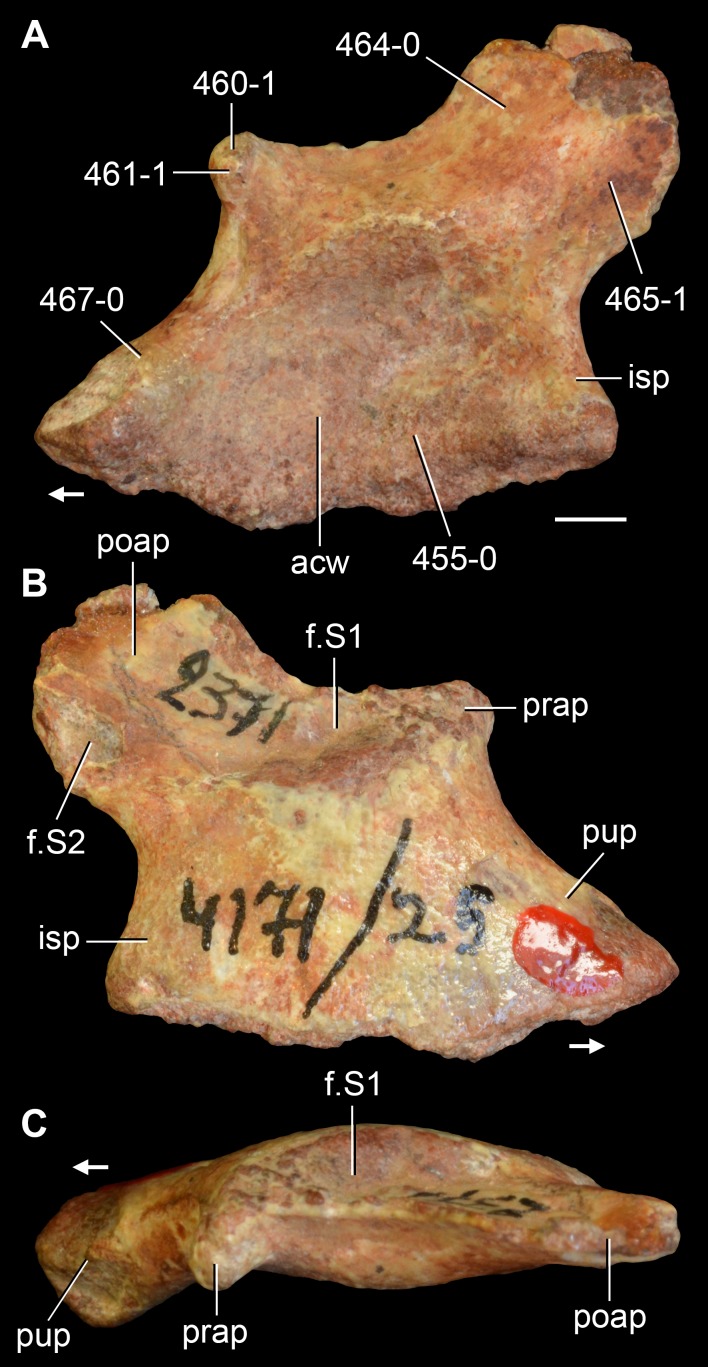
“Exilisuchus tubercularis.”Holotype partial left ilium (PIN 4171/25) in (A) lateral; (B) medial; and (C) dorsal views. Numbers indicate character-states scored in the data matrix and the arrows indicate anterior direction. Abbreviations: acw, acetabular wall; f.S1–2, facet for articulation with the first and second sacral ribs, respectively; isp, ischial peduncle; prap, preacetabular process; poap, postacetabular process; pup, pubic peduncle. Scale bar equals 2 mm.